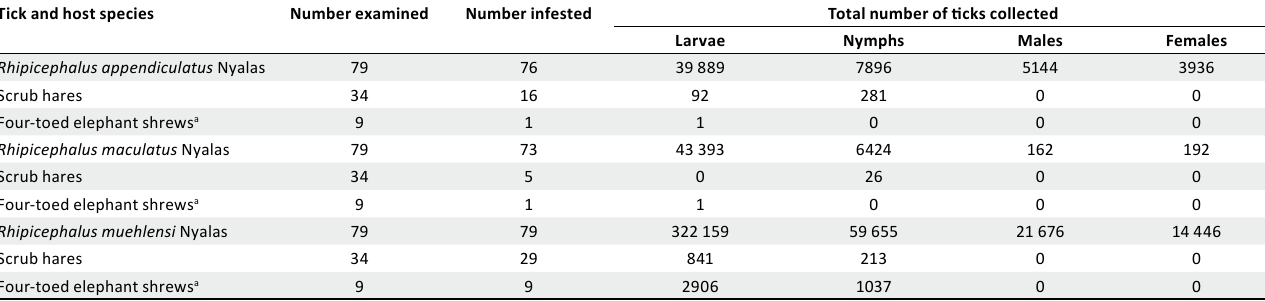
TABLE 2: Host status of four-toed elephant shrews for three sympatric Rhipicephalus species in north-eastern KwaZulu-Natal. Tick and host species Number examined Number infested Total number of ticks collected